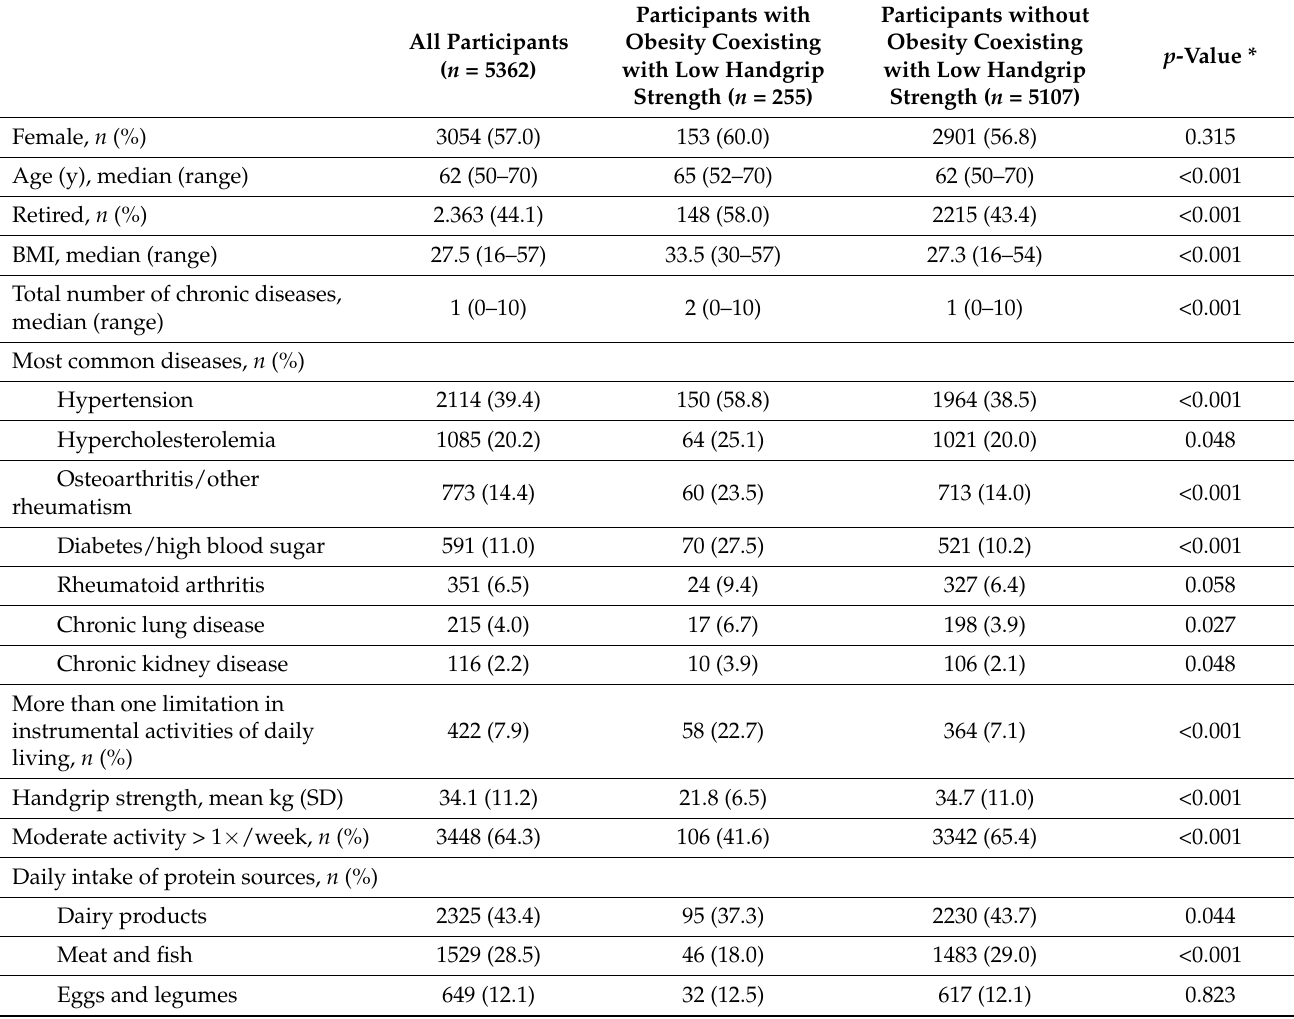
Table 1. Participants’ characteristics, shown separately for persons with and without obesity coexist- ing with low handgrip